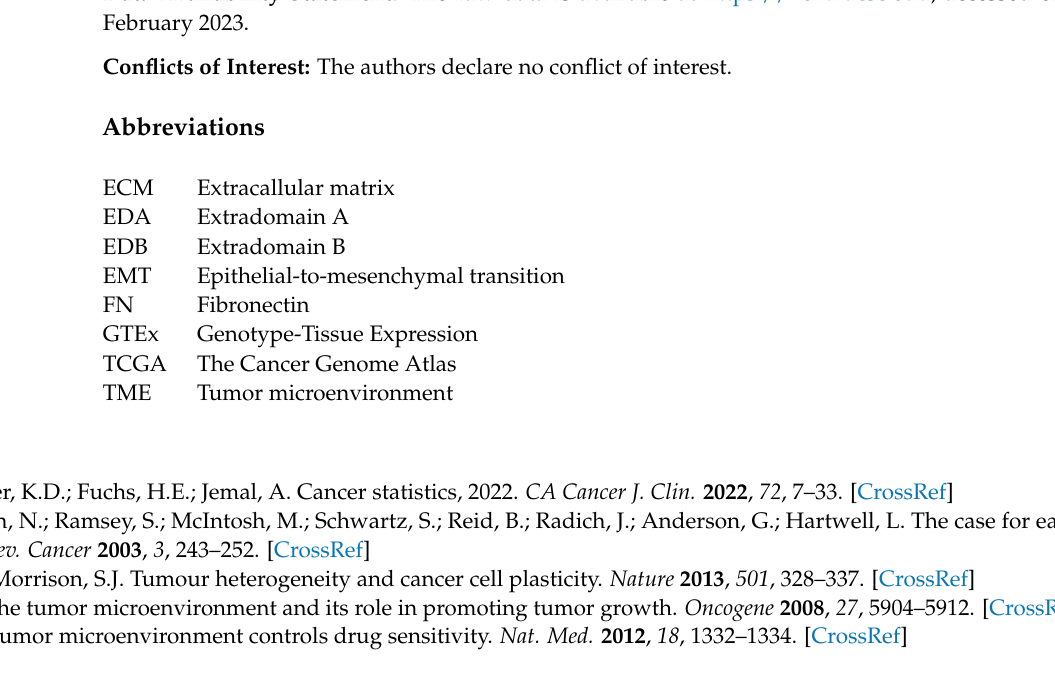
N staging information. Supplementary Figure S4. Confusion matrix for binary classification and calculation of statistics. Supplementary Figure S5. Oncofetal fibronectin expression in other cancer types with histological grading information. Supplementary Table S6. Median survival times of patients based on high and low expression of oncofetal